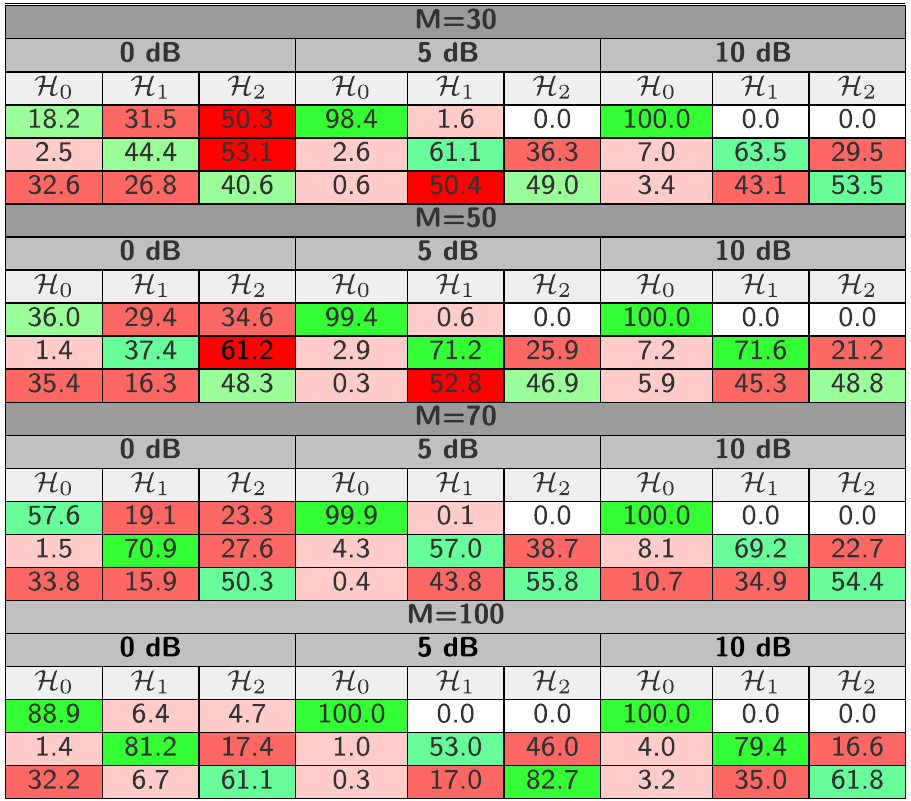
Table 2 Confusion matrices for PUEA